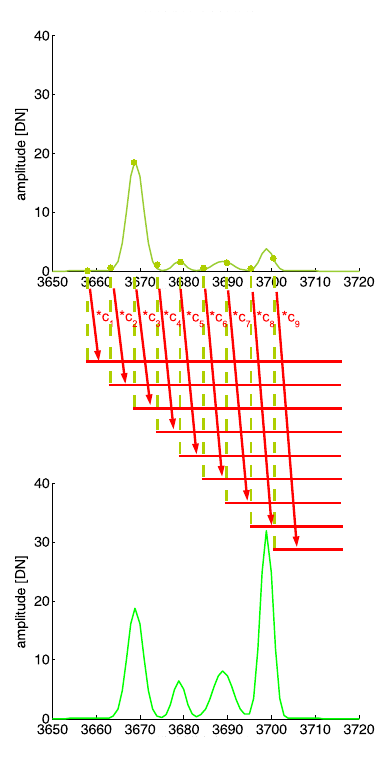
Figure 2: Integral attenuation